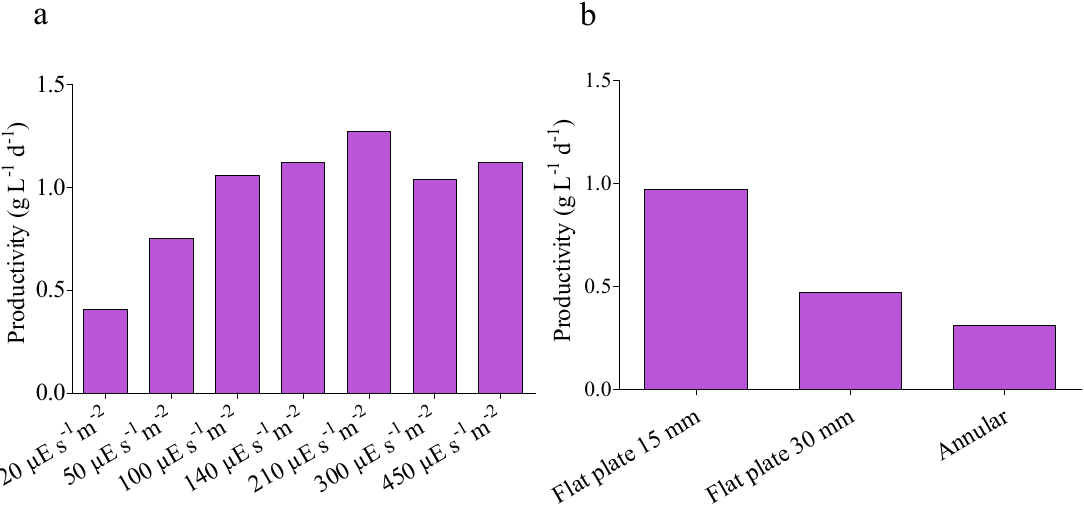
Figure 7. Batch productivity of the cultures grown in different conditions: ( a ) quasi-isoactinic reactor with different photon flux densities; ( b ) reactors with different configurations at incident light intensity I 0 = 210 µE s − 1 m − 2 .